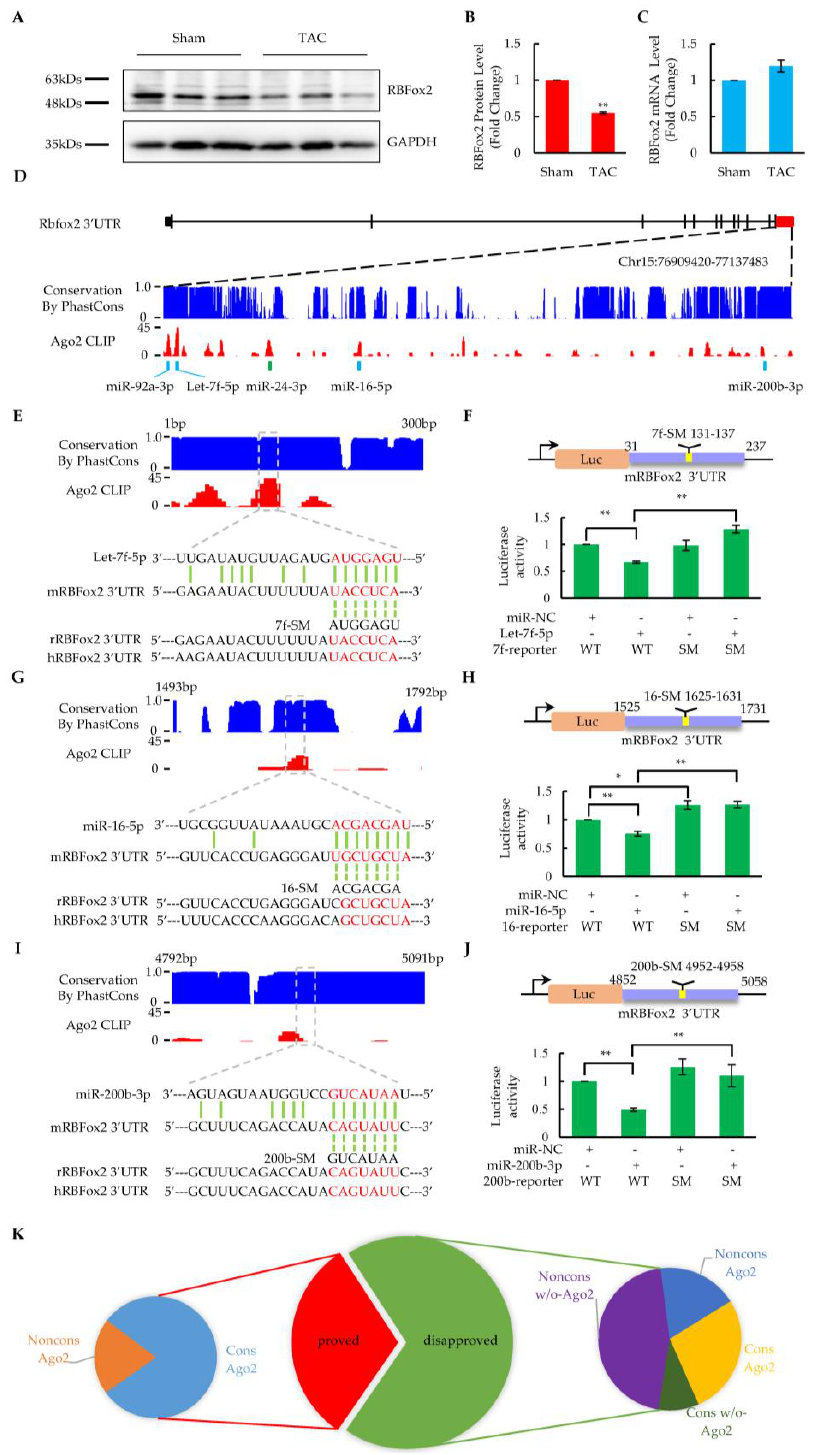
Figure 3. Identification of critical miRNAs targeting to RBFox2. ( A ) Western blotting analysis of RBFox2 protein in the sham and TAC cardiomyocytes ( n = 3 pairs of sham and TAC mice). ( B ) Rel- ative fold change of RBFox2 protein normalized to GAPDH. Values are shown as means ± SEM; ** p < 0.01. ( C ) QPCR analysis of RBFox2 mRNA expression in the sham and TAC cardiomyocytes ( n = 6). Values are shown as means ± SEM. ( D ) Ago2 binding events in the 3′UTR of mouse RBFox2. The blue bar charts represent species conservation and the red bar charts represent Ago2 binding